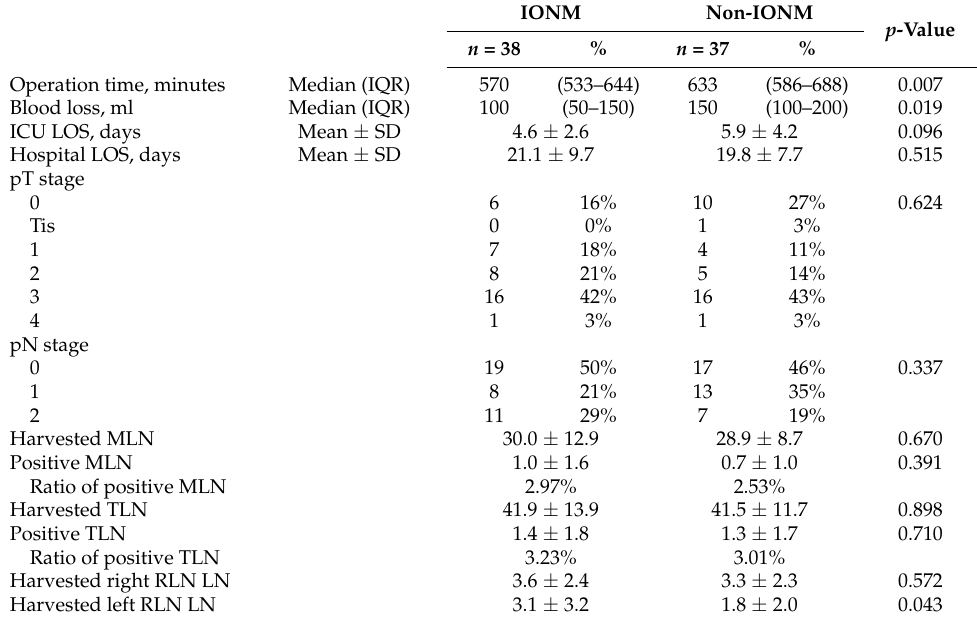
Table 2. Surgical outcome.